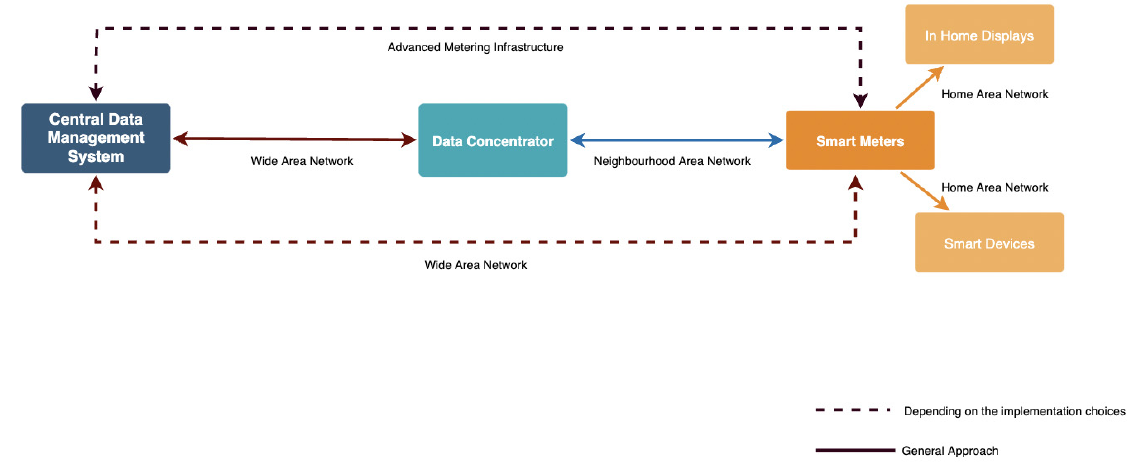
Figure 3. Data Flow Chart on Smart Metering Infrastructure.